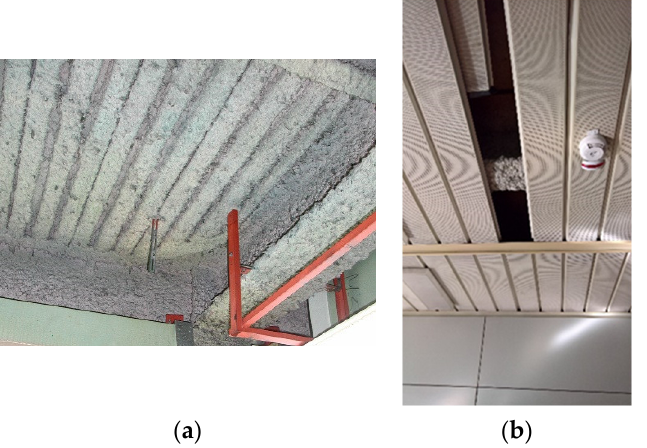
Figure 1. ( a ) Asbestos sprayed on load-bearing structures of a building. ( b ) Under normal use conditions, the friable ACM was covered by metal suspended ceiling.